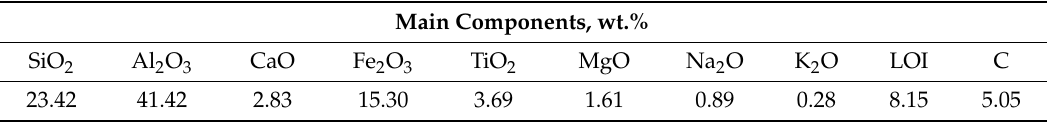
Table 5. Chemical composition of the solid residue (#4 from Table 4) after CFA leaching by NaOH. Main Components,